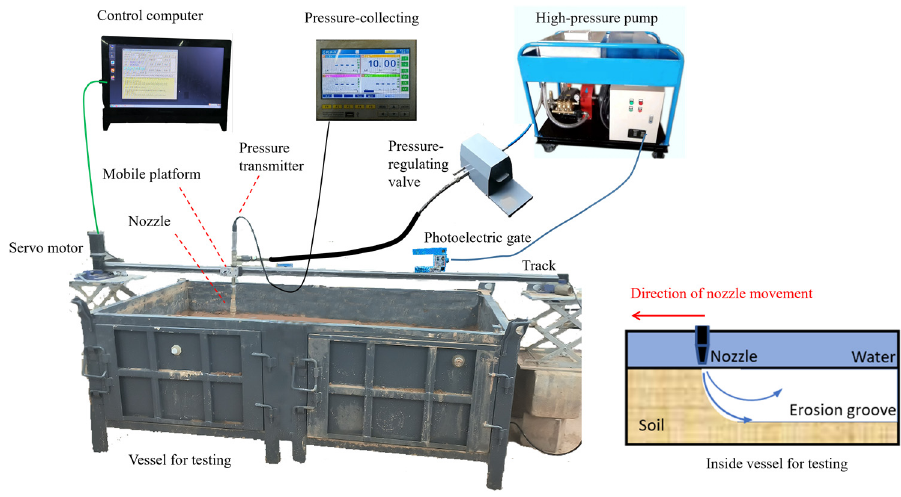
Figure 1. Schemes follow the same